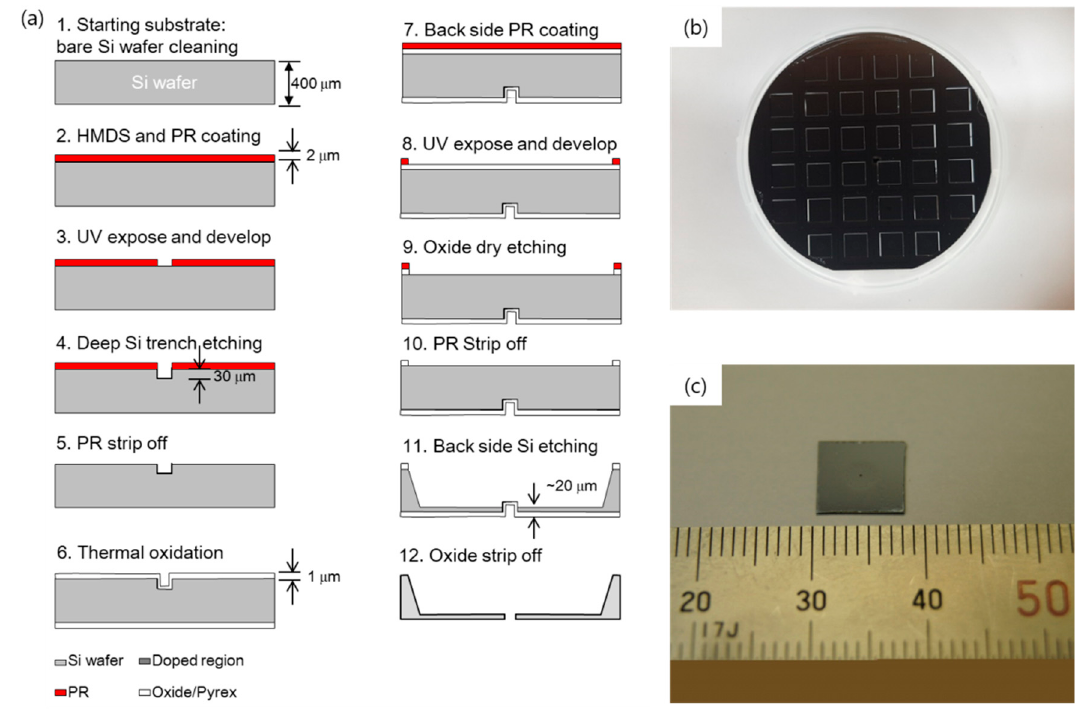
Figure 6. ( a ) Schematic diagram of the fabrication process of a Si electron lens; ( b , c ) Si electron lens wafer fabricated using the MEMS process.